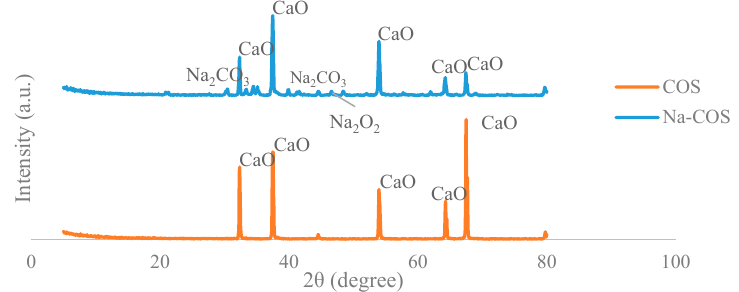
Figure 1. X-ray diffraction patterns of calcined oyster shell (COS) and NaOH-impregnated COS (Na-COS).